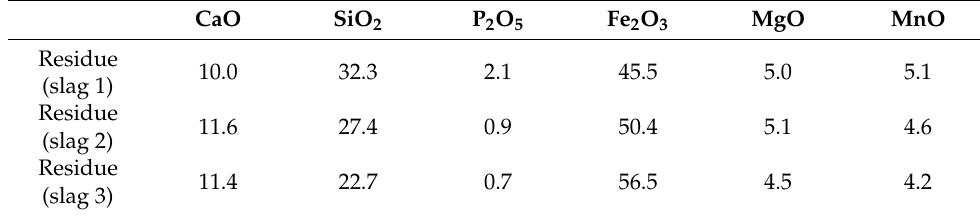
Table 3. Composition of residues after leaching in hydrochloric acid solution at pH 4 (mass%).